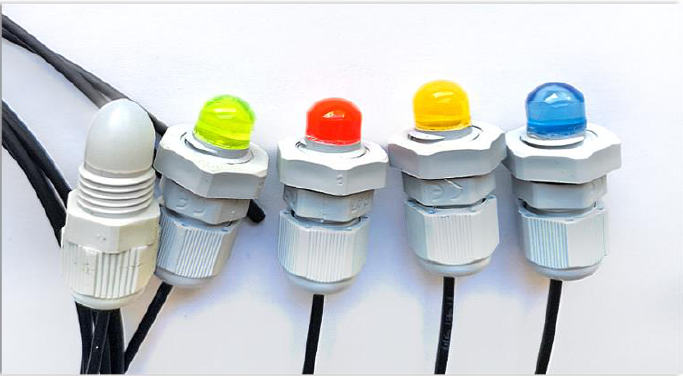
Figure 2. Series of fabricated luminescent sensor heads.